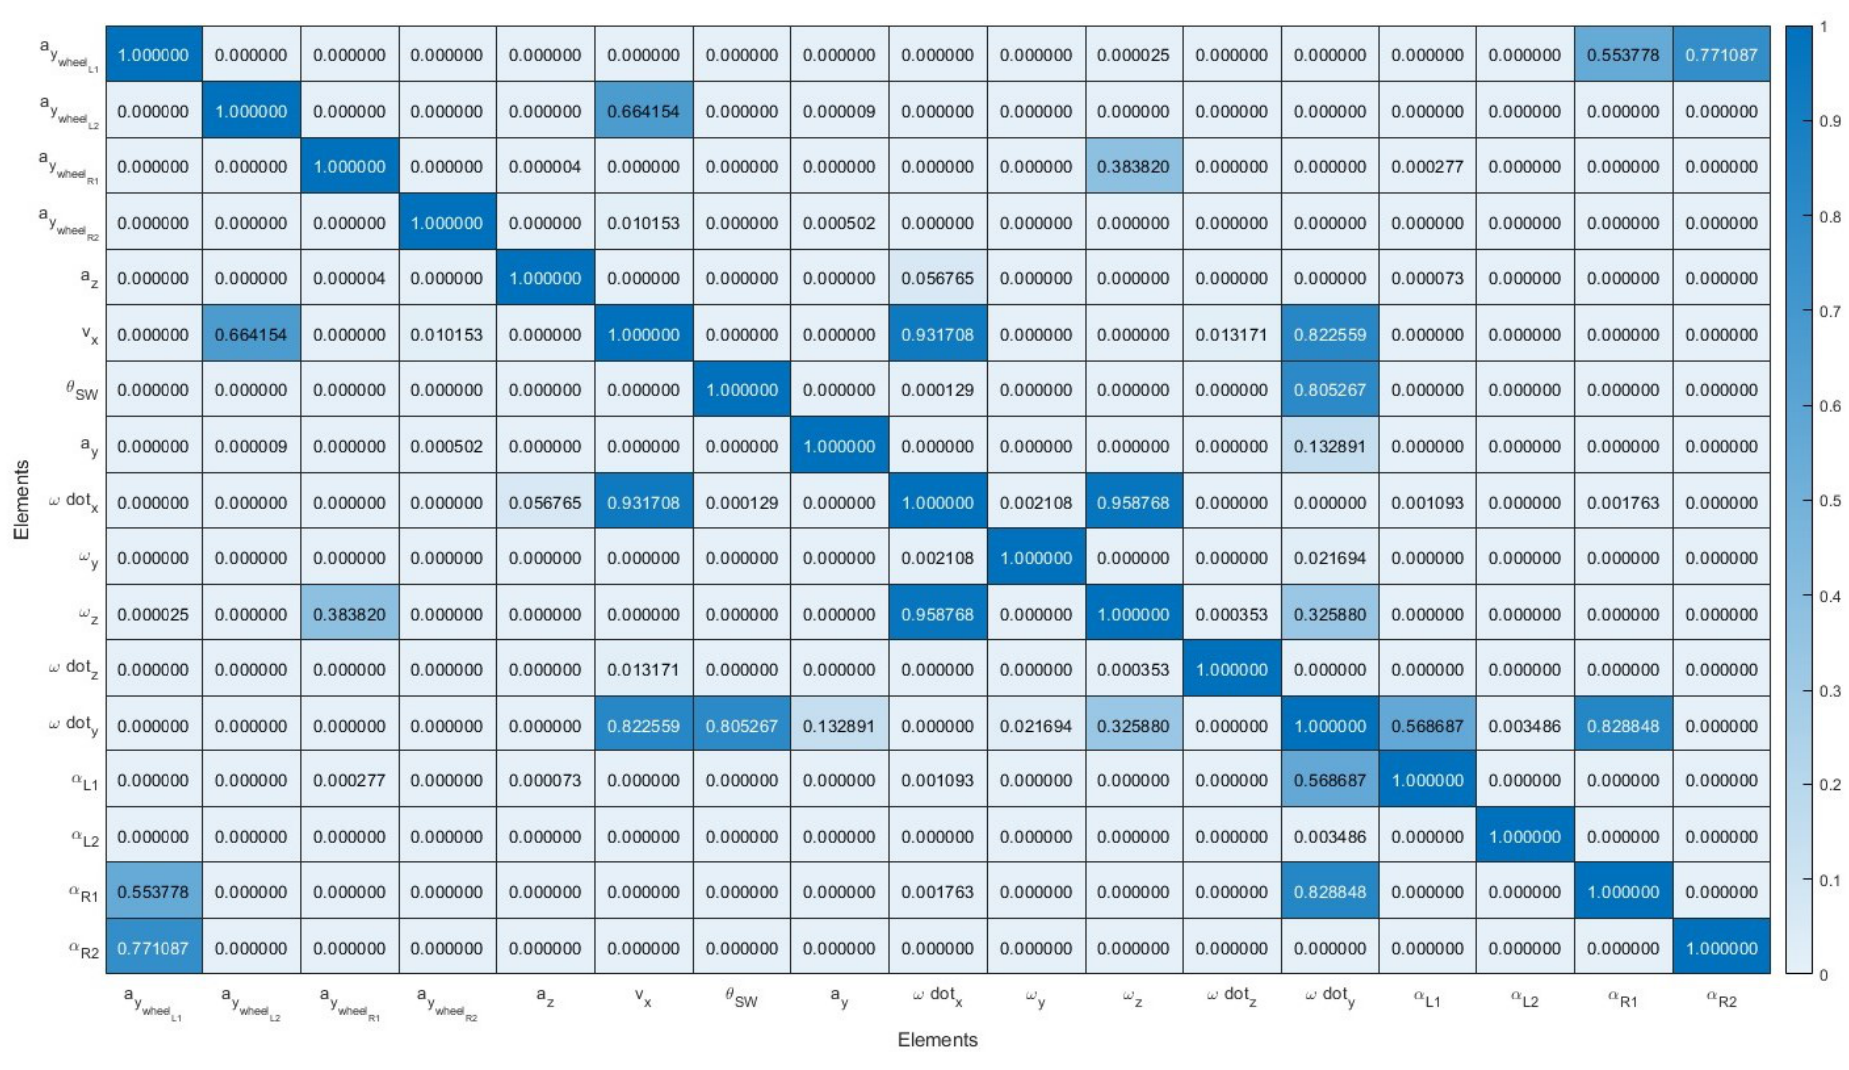
Figure 6. Correlation heatmap of final